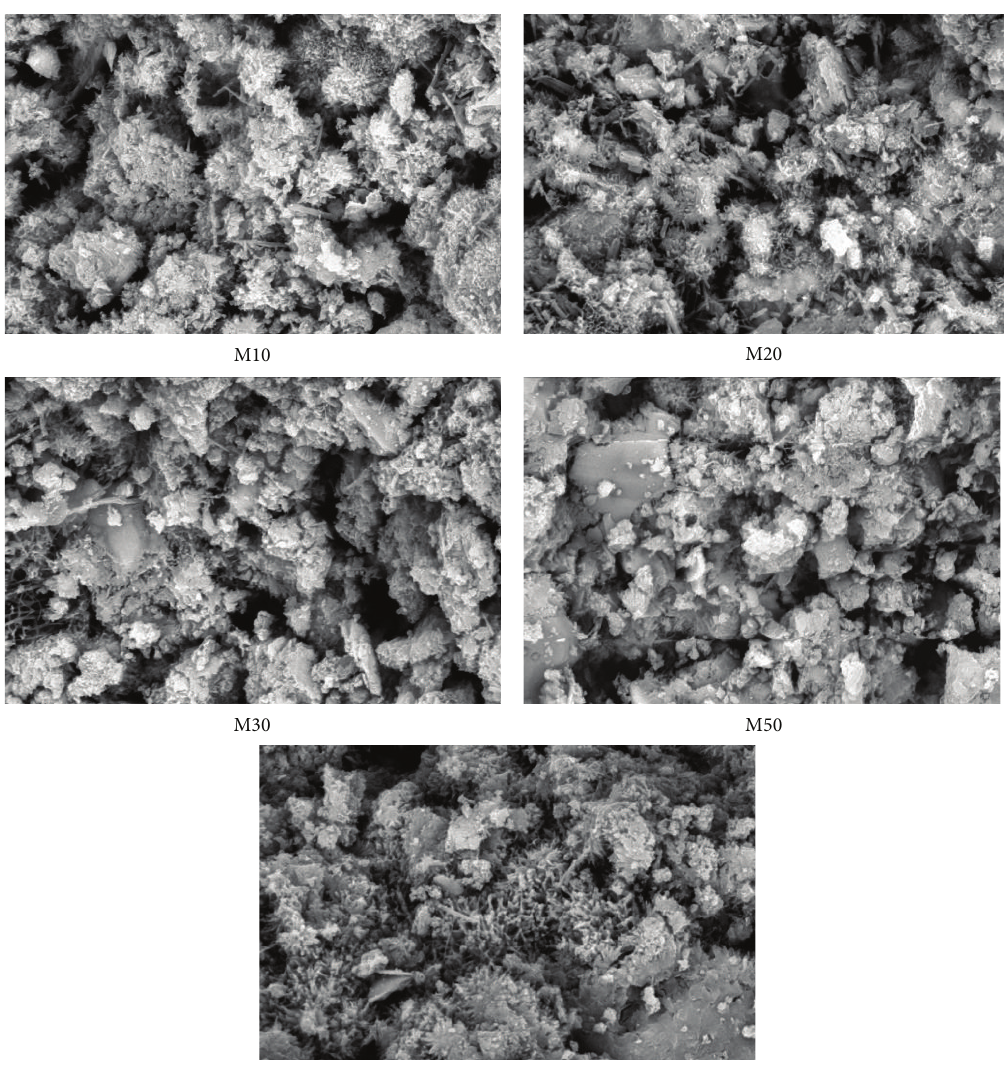
Figure 11: Scanning electron micrographs of mortar containing different content of FA without copolymer